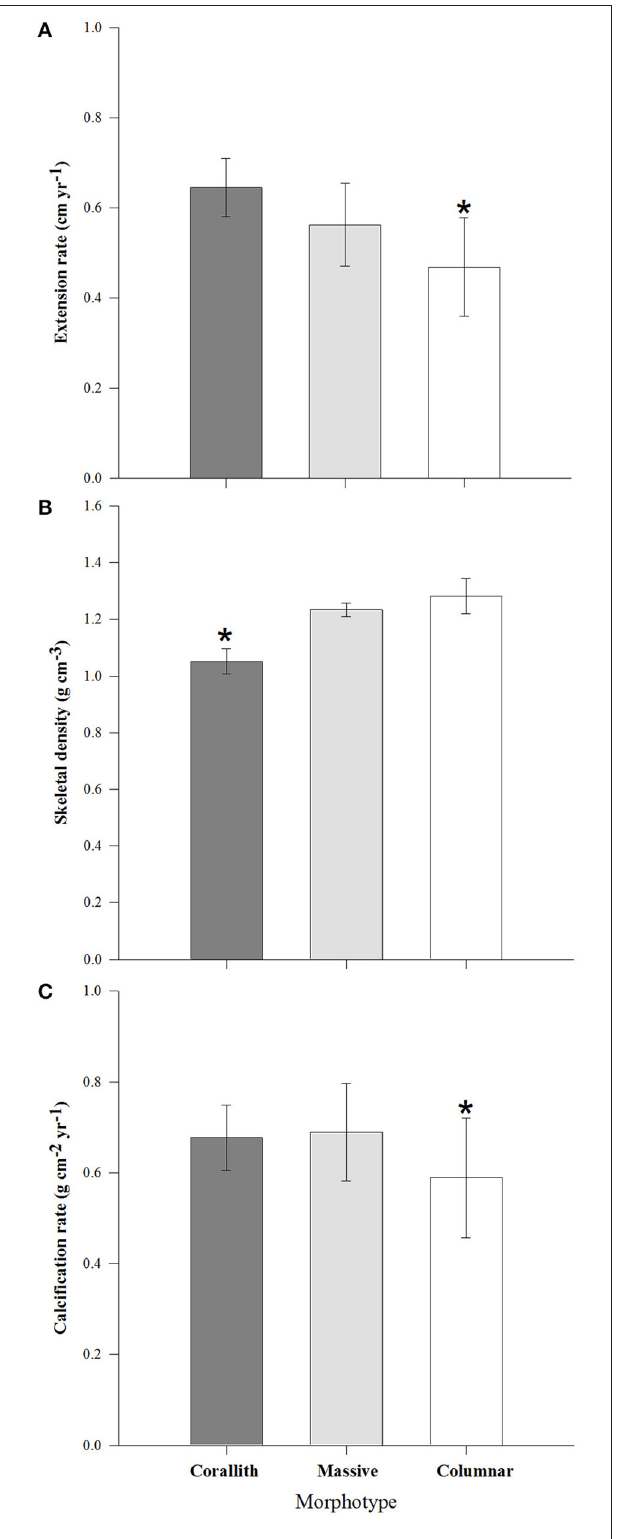
FIGURE 3 | Coral growth parameters ( ± 95% confidence limits) comparison between morphotypes. (A) Extension rate, (B) Skeletal density, and (C) Calcification rate. *denotes statistically significant difference ( P <